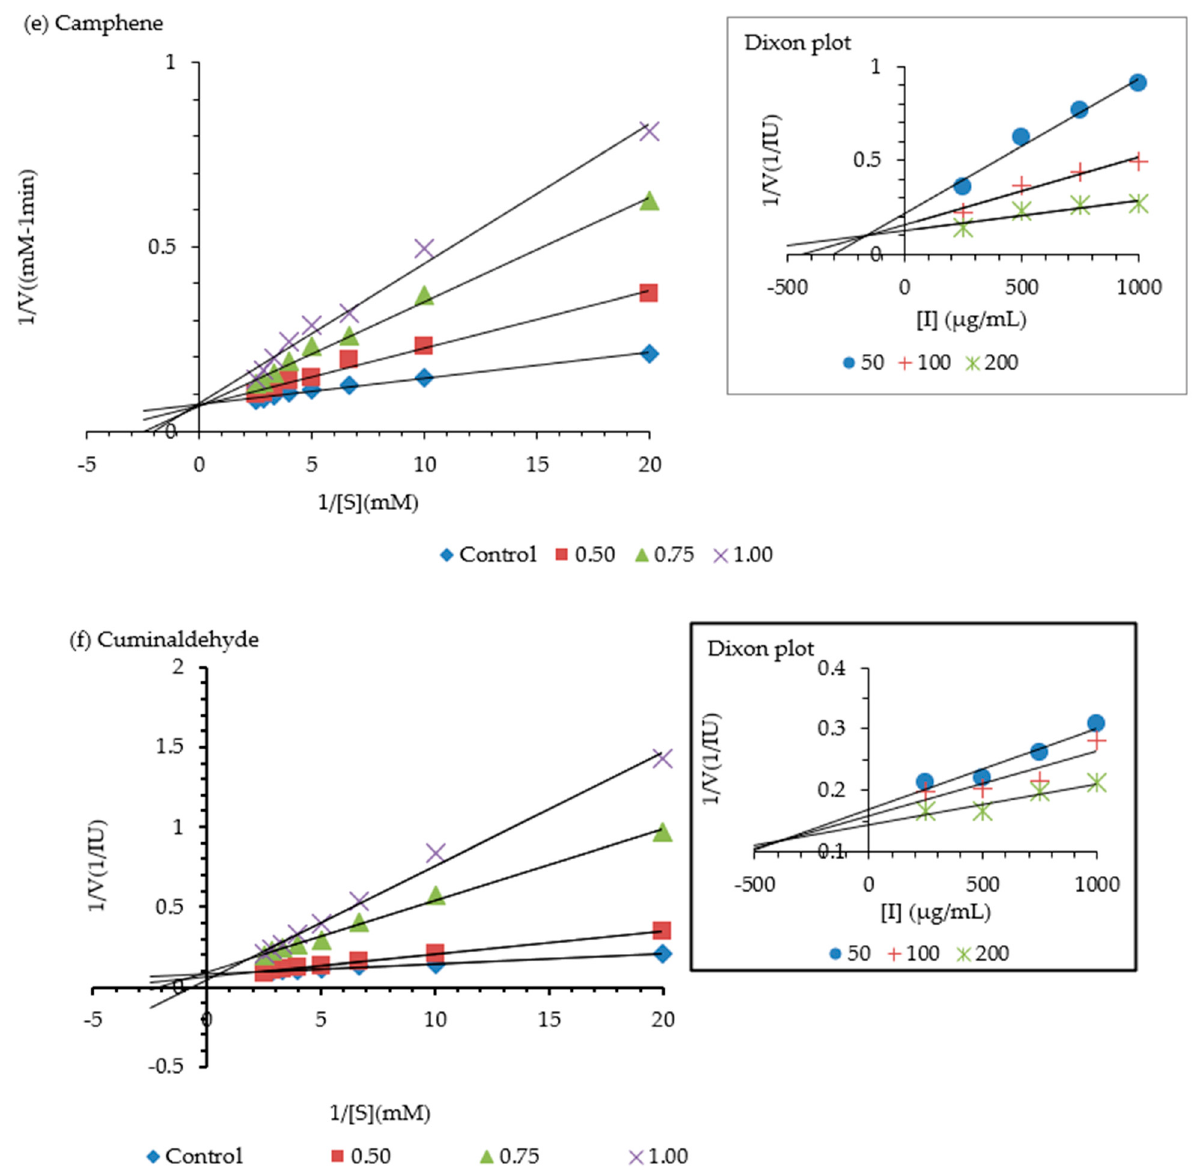
Figure 1. Representative Lineweaver Burk Plots for inhibition of urease enzymatic activity by different concentrations of extracts of C. camphora (mg/mL) ( a – d ), Camphene and Cuminaldehyde (mM) ( e , f ). Representative Dixon Plots as insert graphs of respective samples at different concentrations of urea (µM). Table 2. Summary of mode of urease inhibition by different samples.